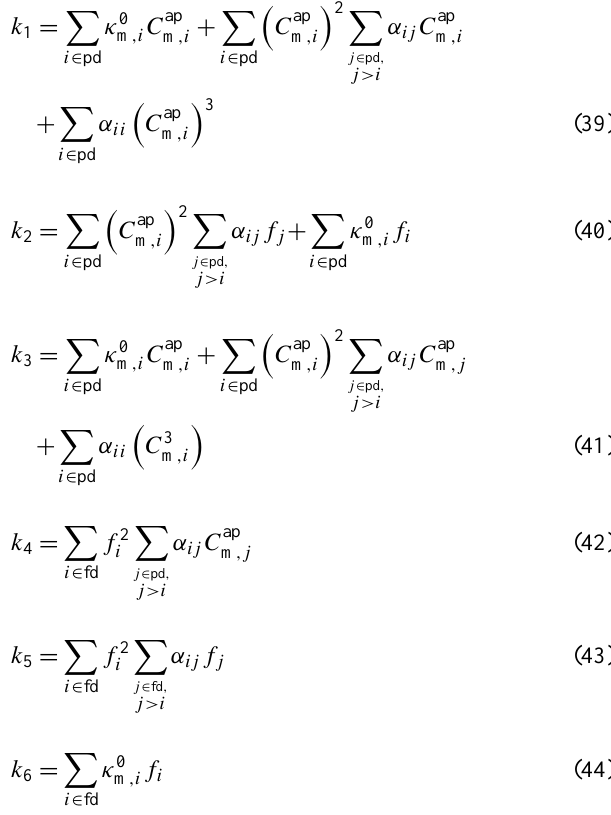
(I), the combination of Eq. (10) and Eq. (36) yields a constant water activity value given by a w = (k 1 + 1 ) − 1 . This